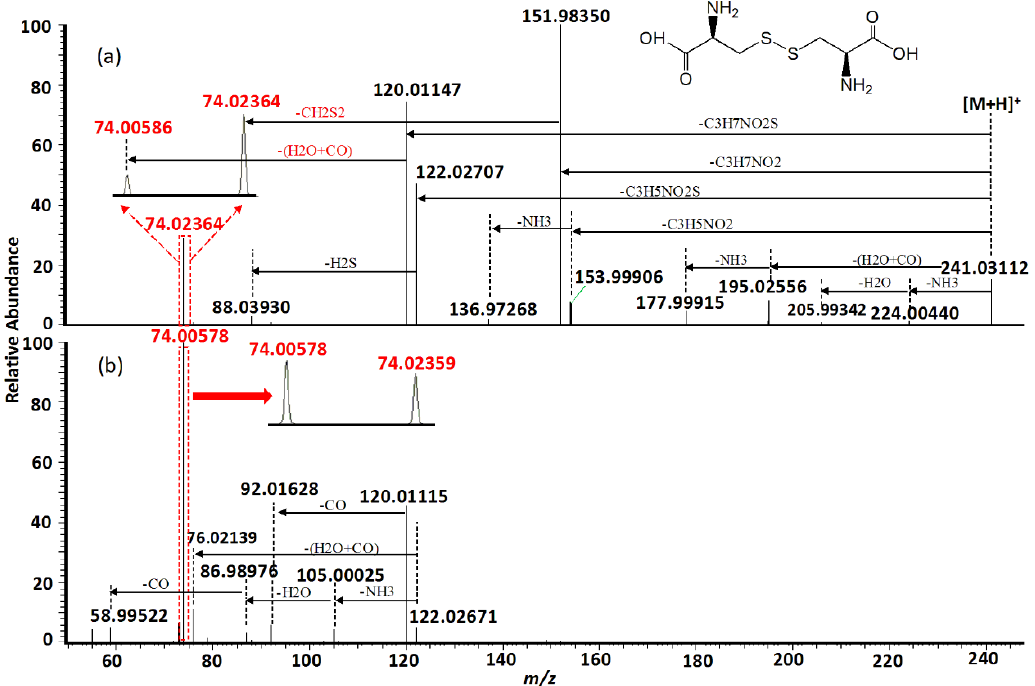
Figure 2. Representative MS/MS spectra of protonated cystine acquired using normalized collision energy (NCE) of ( a ) 30% and ( b ) 70%. Isobaric fragmentations are shown in red.